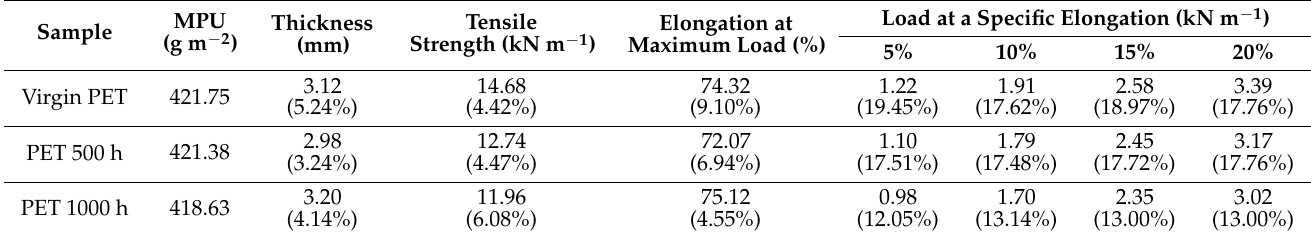
Table 3. Physical properties of the geotextile before and after UV-aging tests.